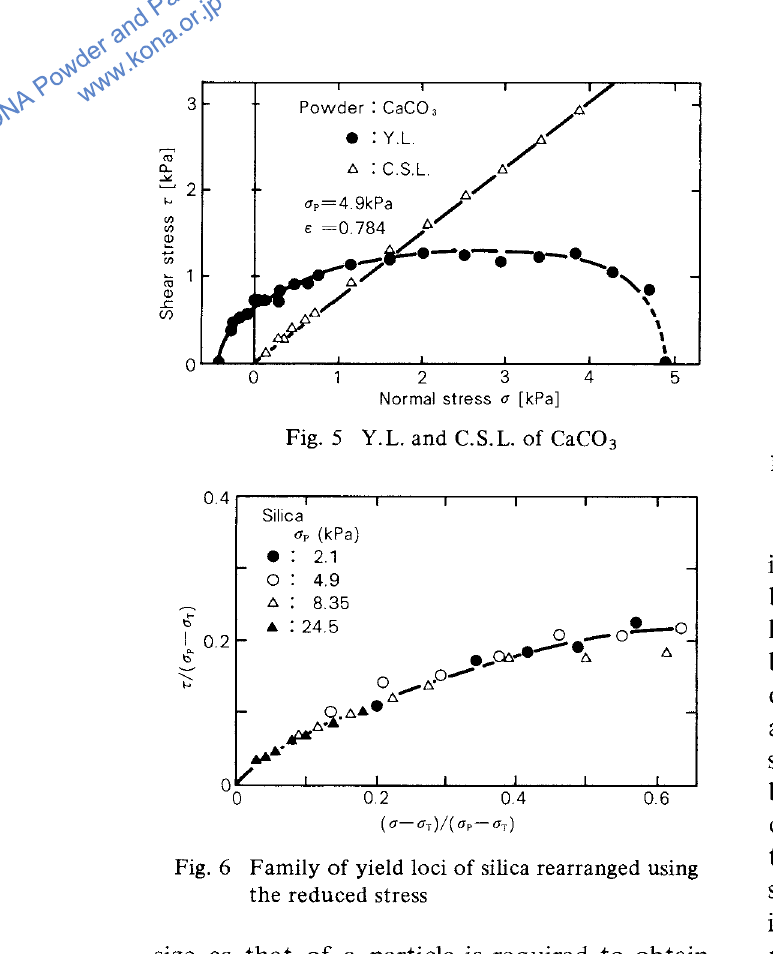
Fig. 6 Family of yield loci of silica rearranged using the reduced stress